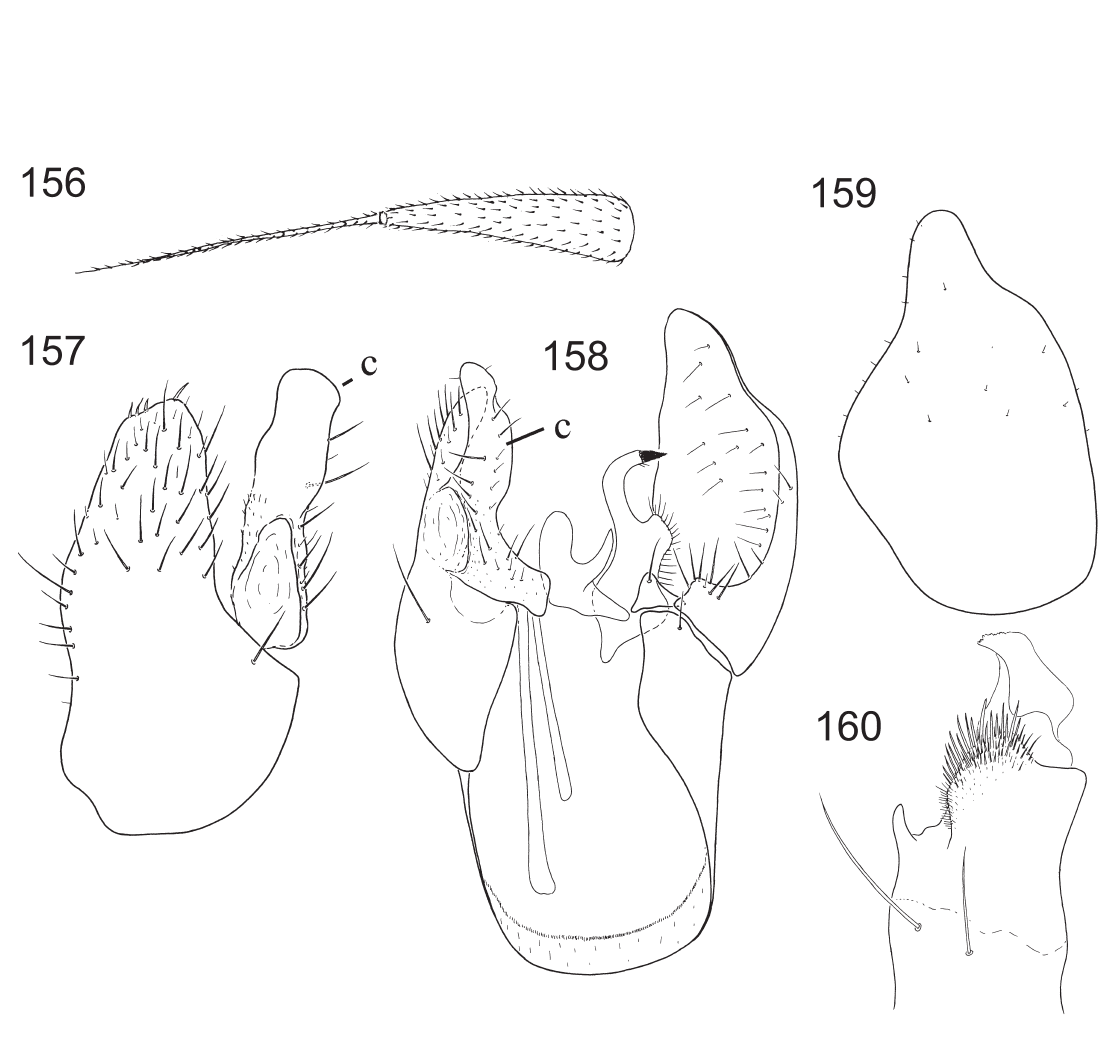
Figs 156-160. Elaphropeza semakau sp. nov., ♂. 156 . postpedicel and stylus of antenna, lateral view. 157 . right epandrial lamella, lateral view. 158 . epandrium with cerci, dorsal view. 159 . left surstylus, lateral view. 160 . tip of hypandrium, ventral